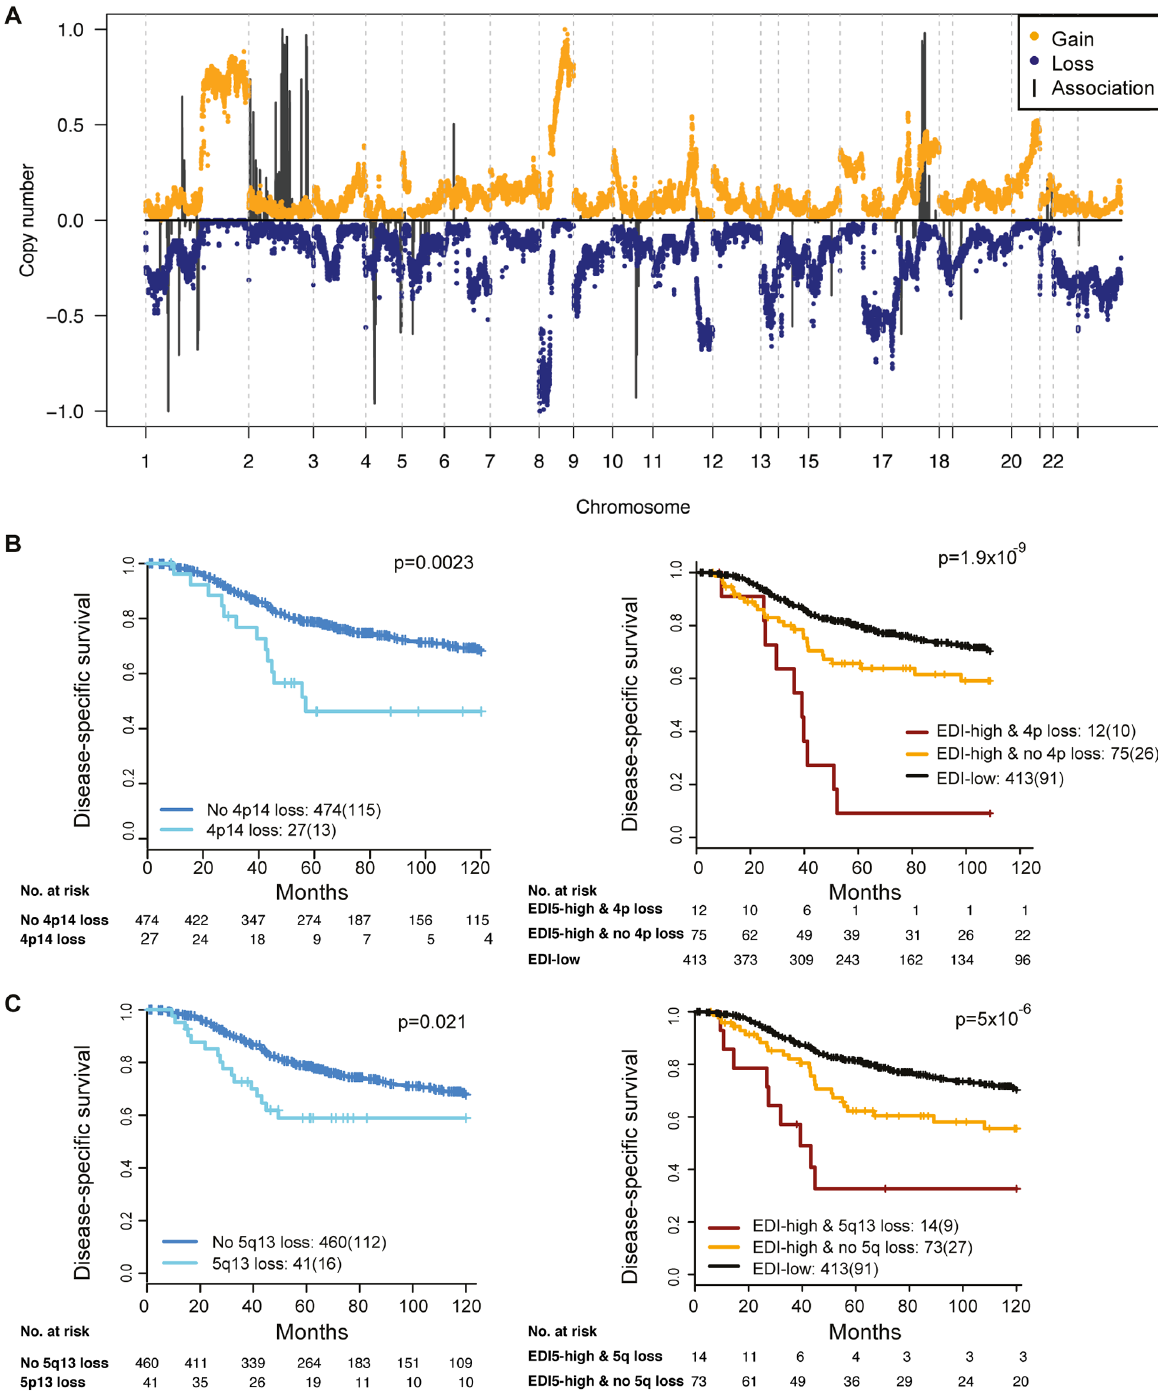
Fig 5. The relationship between ecological heterogeneity and cancer genomic aberrations in 507 grade 3 tumors. (A) Genome-wide copy number aberrations in grade 3 breast tumors and genomic coordinates of genes with copy number aberrations enriched in the EDI-high group. Lengths of black lines denote level of enrichment significance with copy number gains (above the horizontal line) or losses (below the horizontal line). (B) Kaplan – Meier curves illustrating the duration of disease-specific survival in grade 3 breast cancer patients according to copy number loss of the 4p14 region (left) and the EDI-high group with additional information of 4p14 copy number loss (right). (C) Kaplan – Meier curves illustrating the duration of disease-specific survival according to copy number loss of the 5q13 region (left) and the EDI-high group with additional information of 5q13 copy number loss